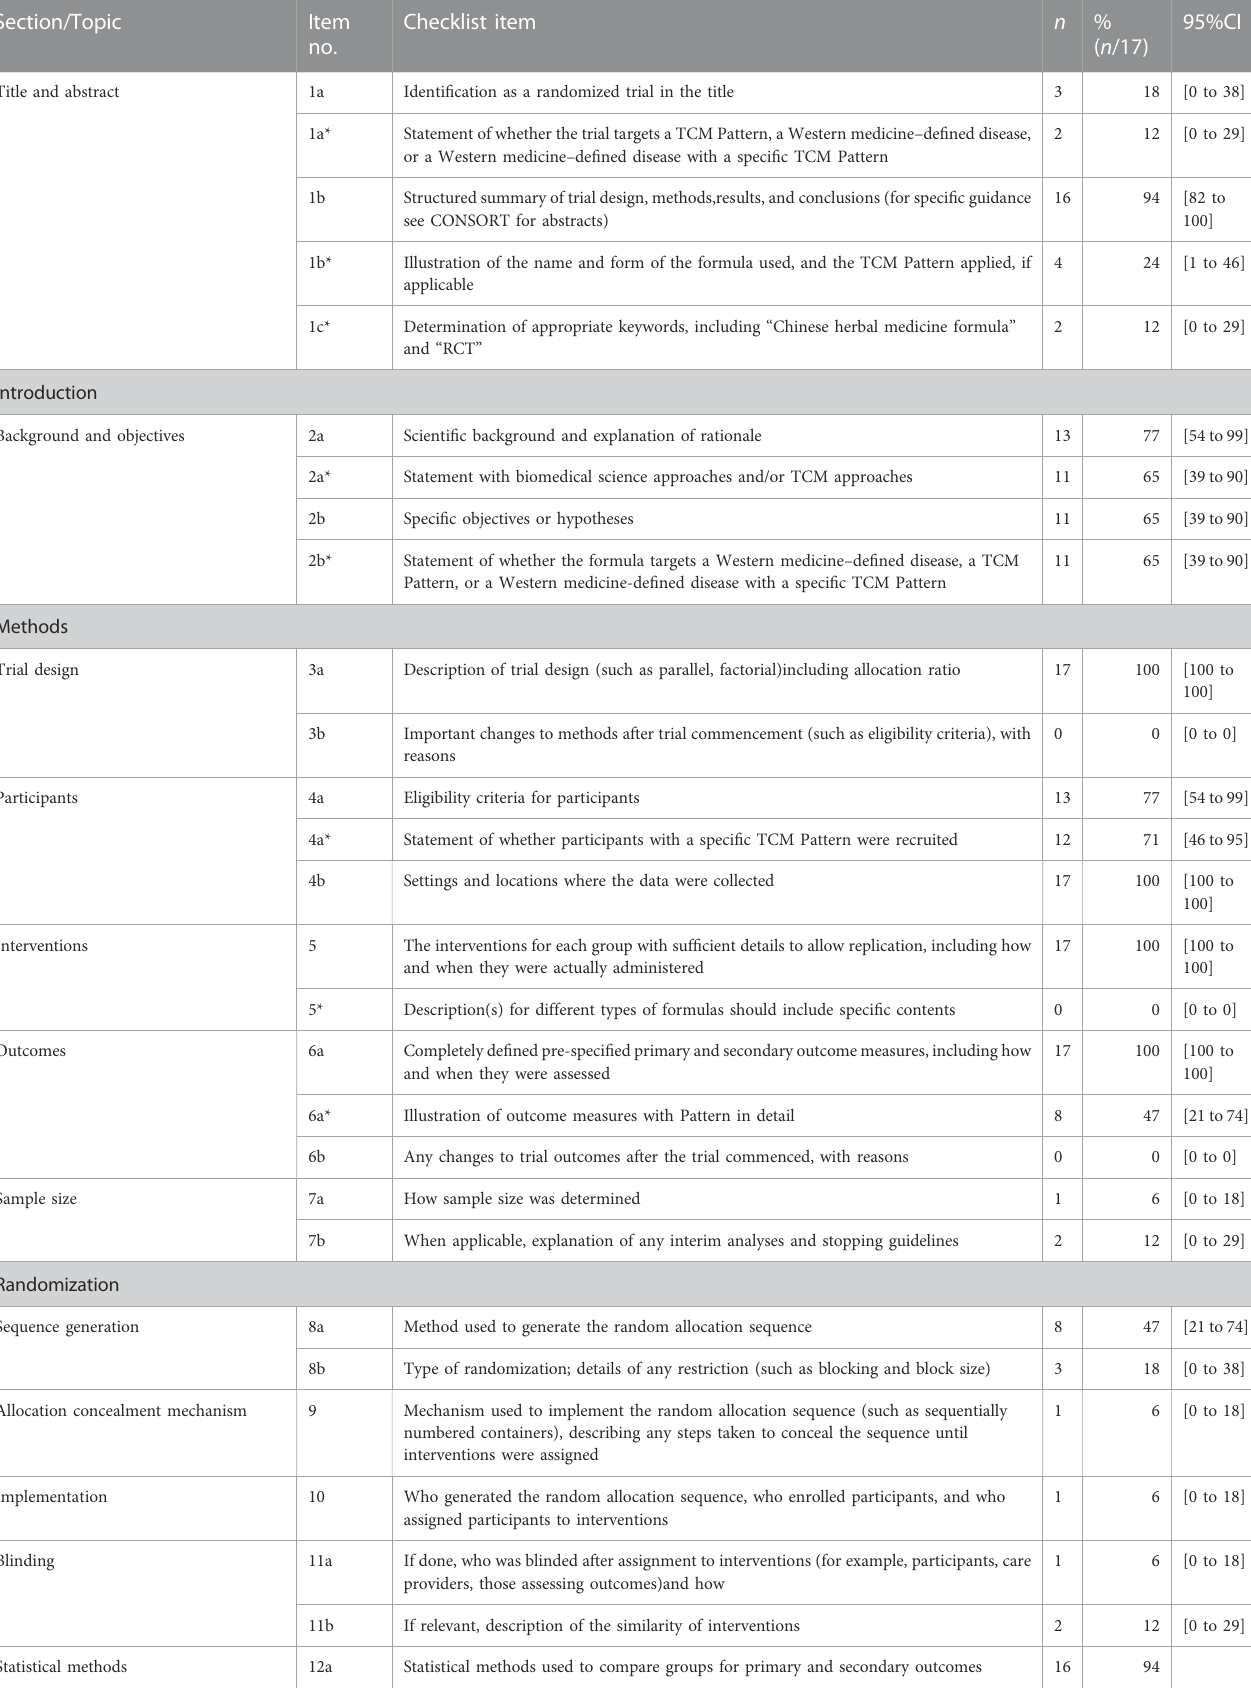
TABLE 2 The reporting number and percentage for each item of the CONSORT and CONSRT-CHM checklist of the included 17 studies.